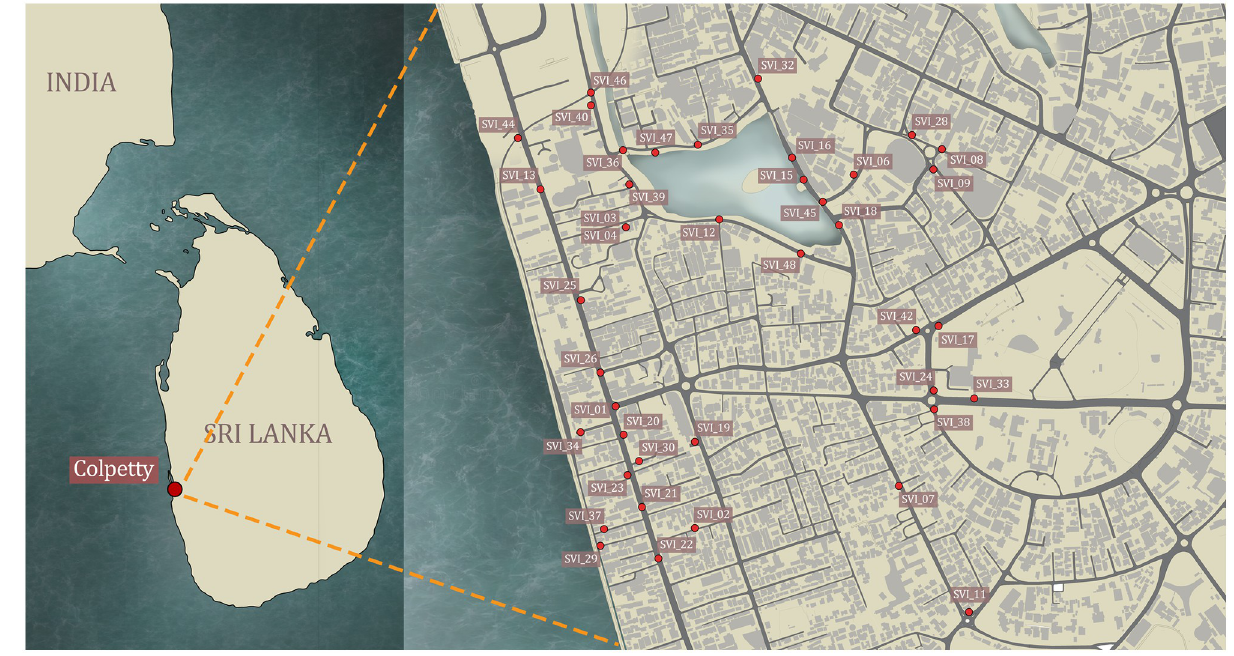
Fig 1. Case study locations of selected 48 SVIs—One kilometre radius from Colpetty Junction, Colombo Sri Lanka.